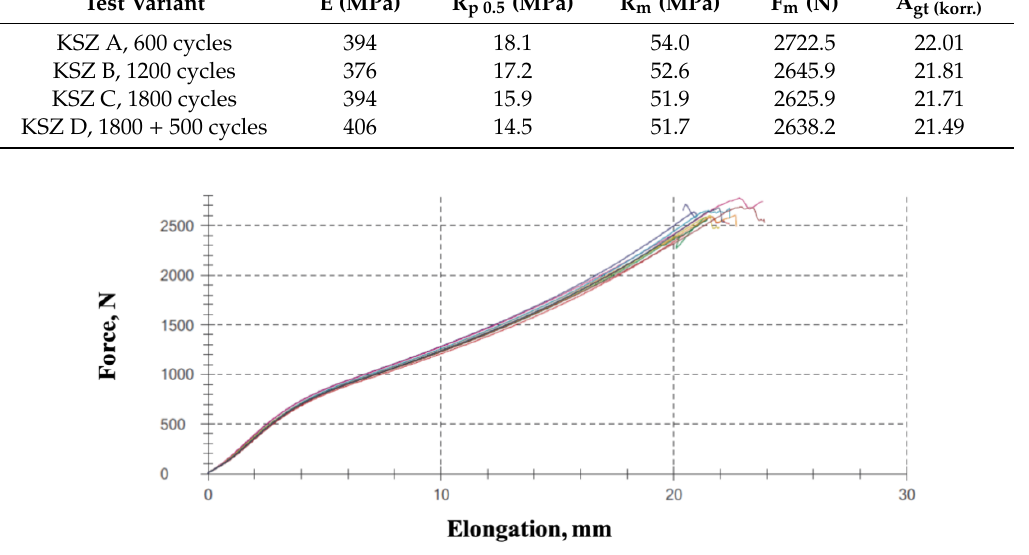
Figure 7. Force versus elongation of conveyor belt samples, KSZ B, 1200 cycles.